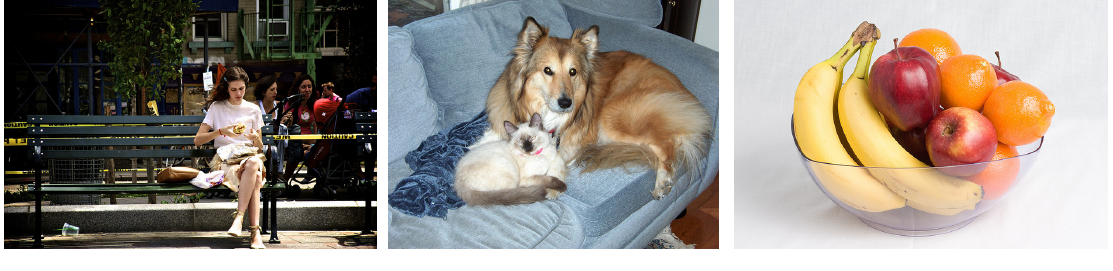
Figure 5. Some generate captions of our model from MSCOCO test